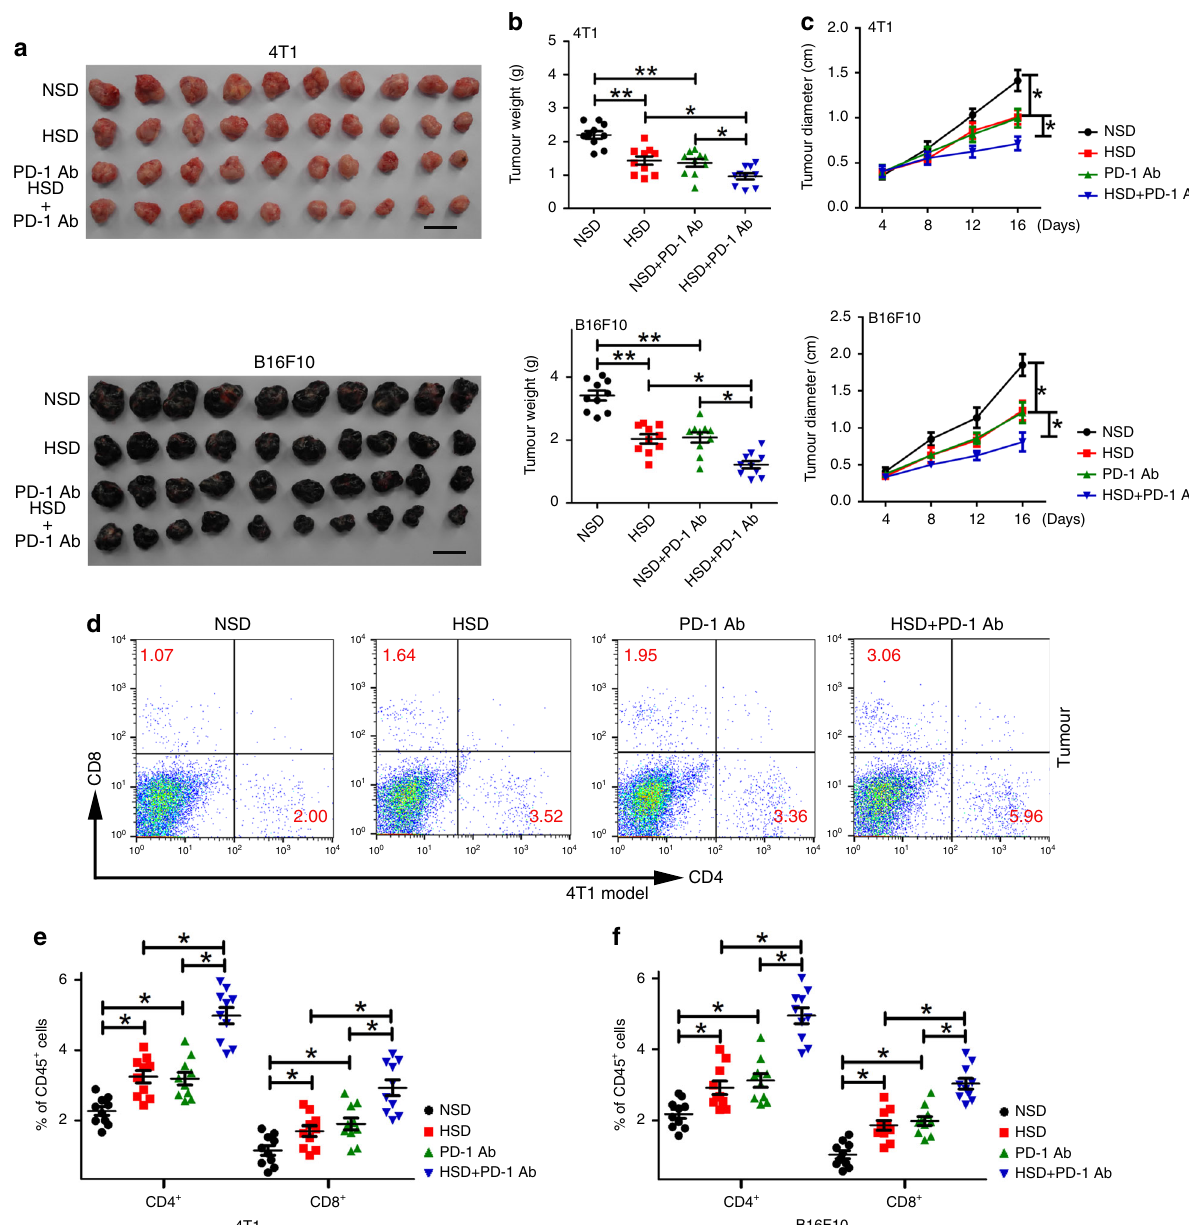
Fig. 6 Combined treatment with HSD and the anti-PD-1 antibody in tumour-bearing mice. a – c Female mice were subcutaneously implanted with 1 × 10 6 4T1 or B16F10 cells after starvation for 1 day and randomly assigned to receive the NSD or HSD for 16 days. On days 4, 8 and 12, mice were injected with 4 mg kg − 1 control IgG antibody or 2 mg kg − 1 anti-PD-1 via i.p. administration ( n = 10 for each group). Images of tumours harvested from mice are shown, and tumour size was examined. Scale bar, 1 cm. d – f Tumours collected at day 16 were dissociated, and the proportions of CD4 + and CD8 + T cells in the CD45 + cell population were determined by fl ow cytometry. For all panels, n = 10 mice per group. One-way ANOVA with post hoc Bonferroni correction; * p < 0.05 and ** p < 0.01. Data are representative of three independent experiments. Data are presented as dot plots extending to minimum and maximum values in one independent experiment, and bars are presented as the mean ± SEM of ten individual mice; each dot represents one mouse. Source data are provided as a Source Data fi